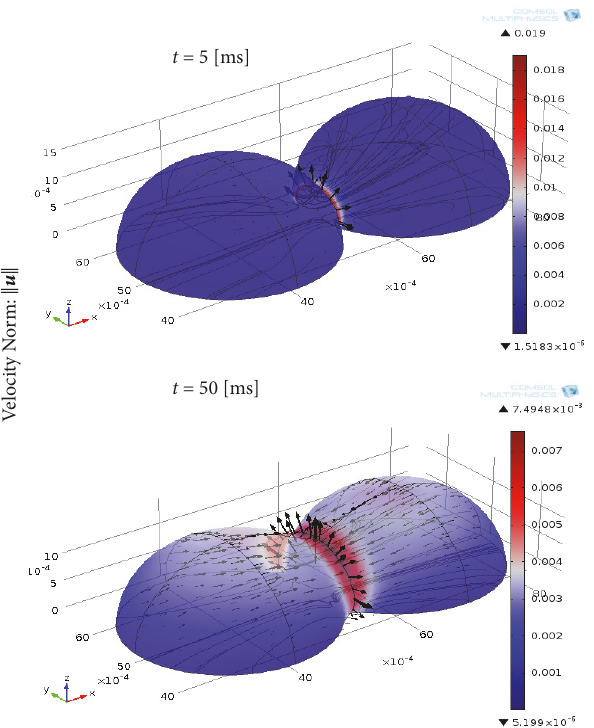
Figure 9: Three-dimensional plots of the velocity norm ‖ u ‖ of two interacting droplets of the same radius 𝑅 1 = 𝑅 2 at times 𝑡 = 5 , 50 [ms].